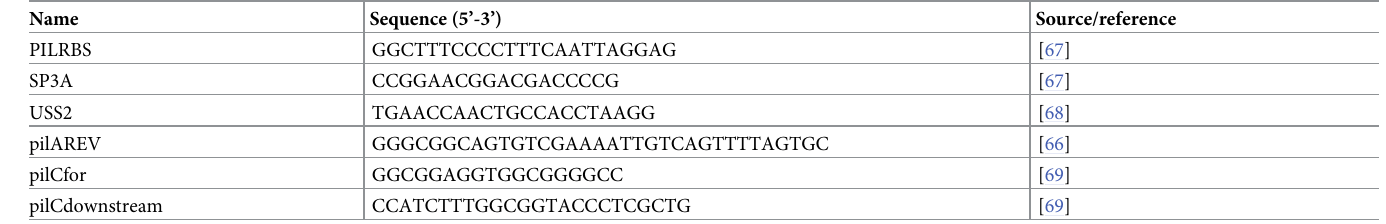
Table 3. Oligonucleotides.